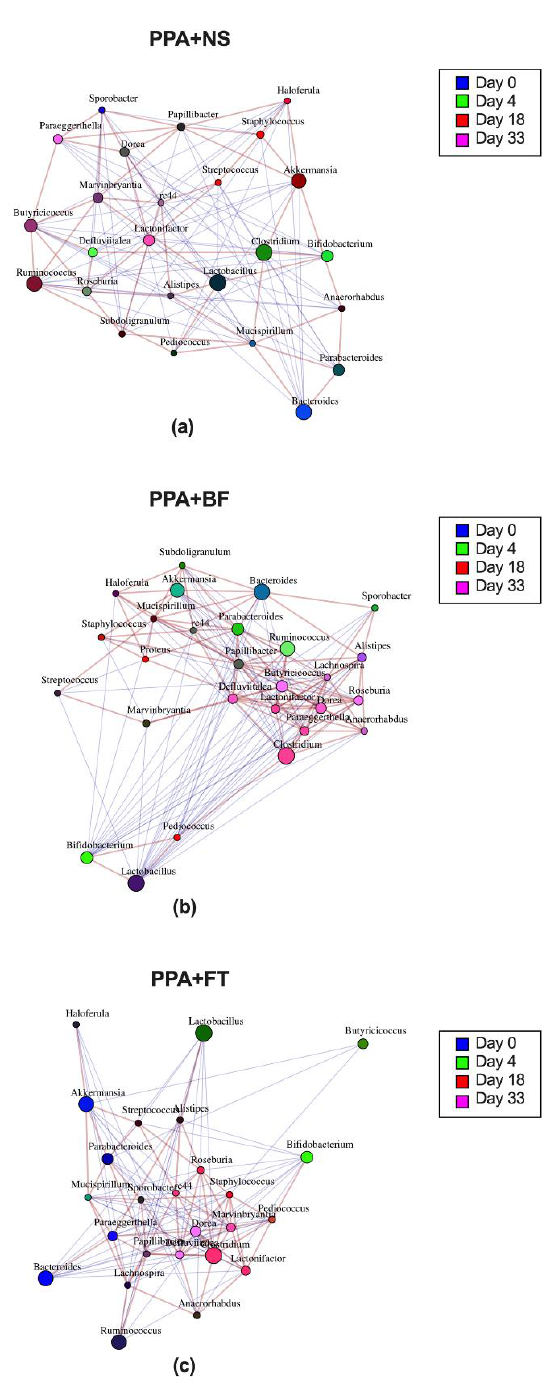
Figure 7. Spearman correlation co-occurrence network showing the 25 most abundant genera. The size of the circle is proportional to the bacterial relative abundance, and the red and blue lines represent positive and negative correlation, respectively. Circle colors denote the day of sample collection. Propionic acid (PPA + NS) control group ( a ), Bifidobacterium (PPA + BF) treated group ( b ), fecal microbiota transplantation treated (PPA + FT) group ( c ).